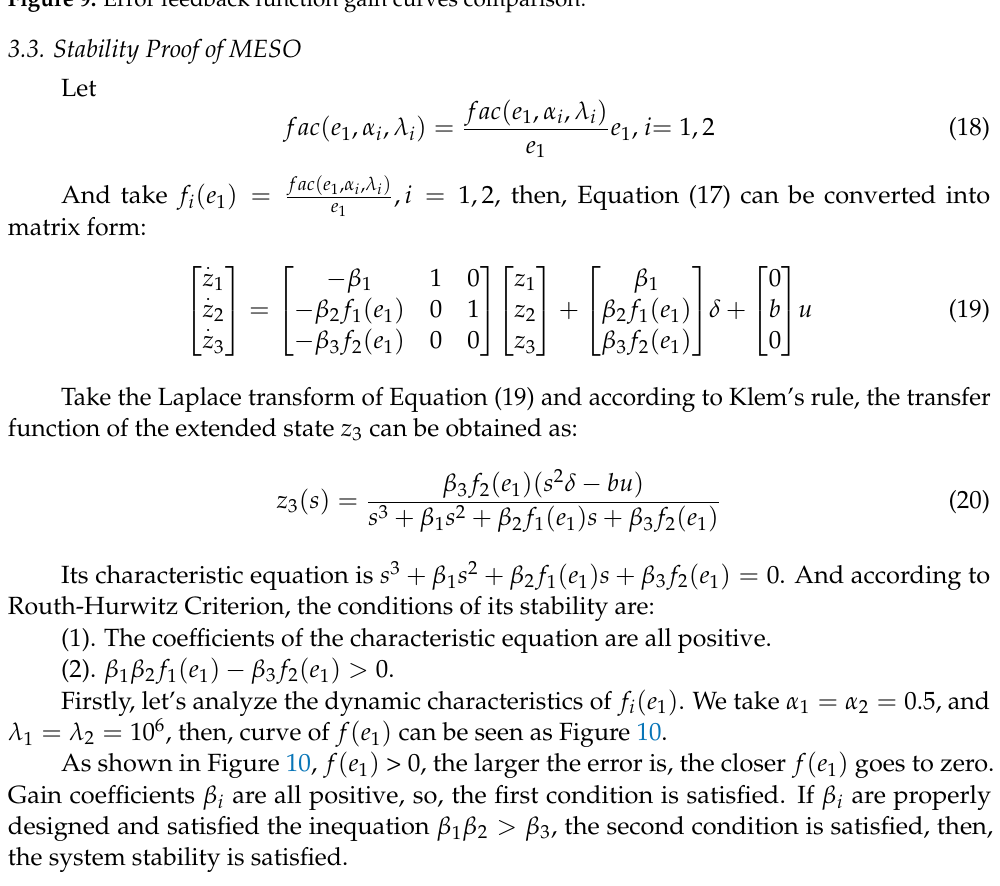
Figure 9. Error feedback function gain curves comparison.